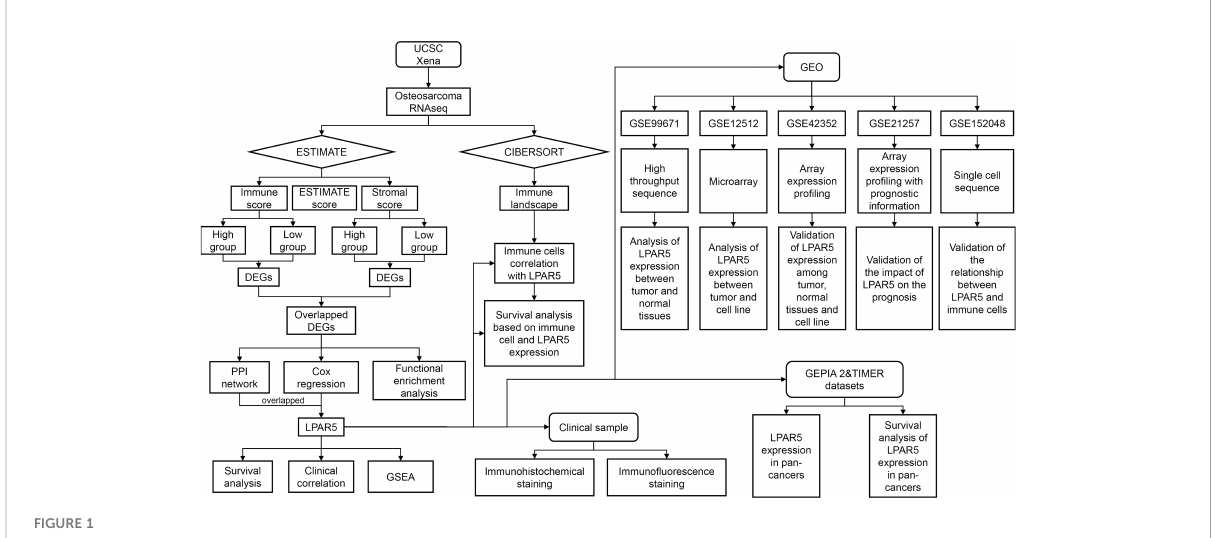
FIGURE 1 Analysis fl ow chart of our